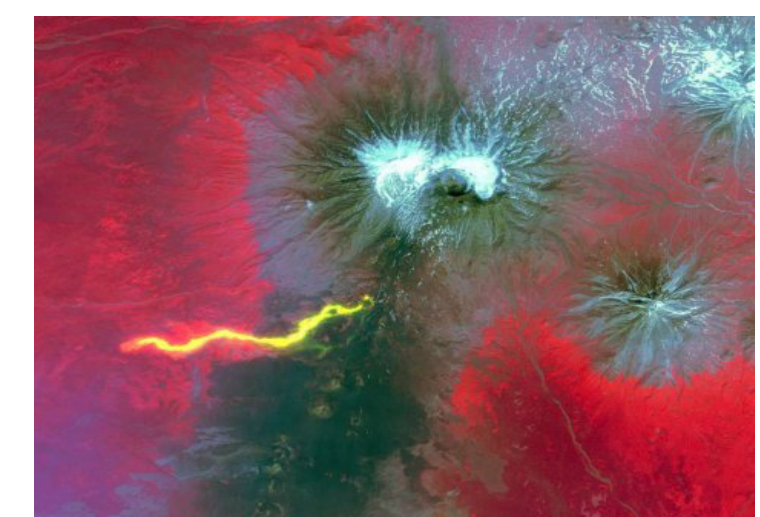
Figure 14 – Infrared image of the EO-1 NASA satellite for the Earth observation